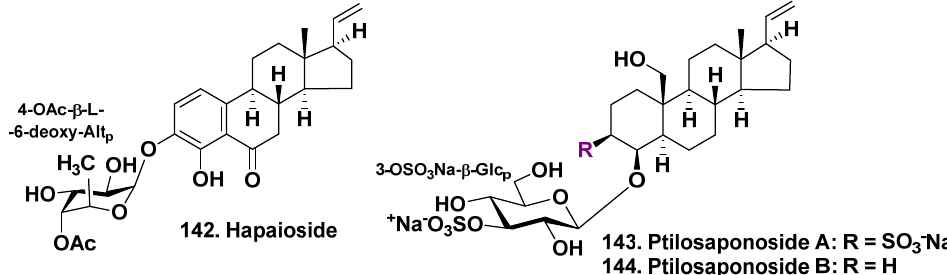
Figure 17. Hapaioside 142 from Cribrochalina olemda and ptilosaponosides 143 , 144 from Ptilocaulis spiculifer .